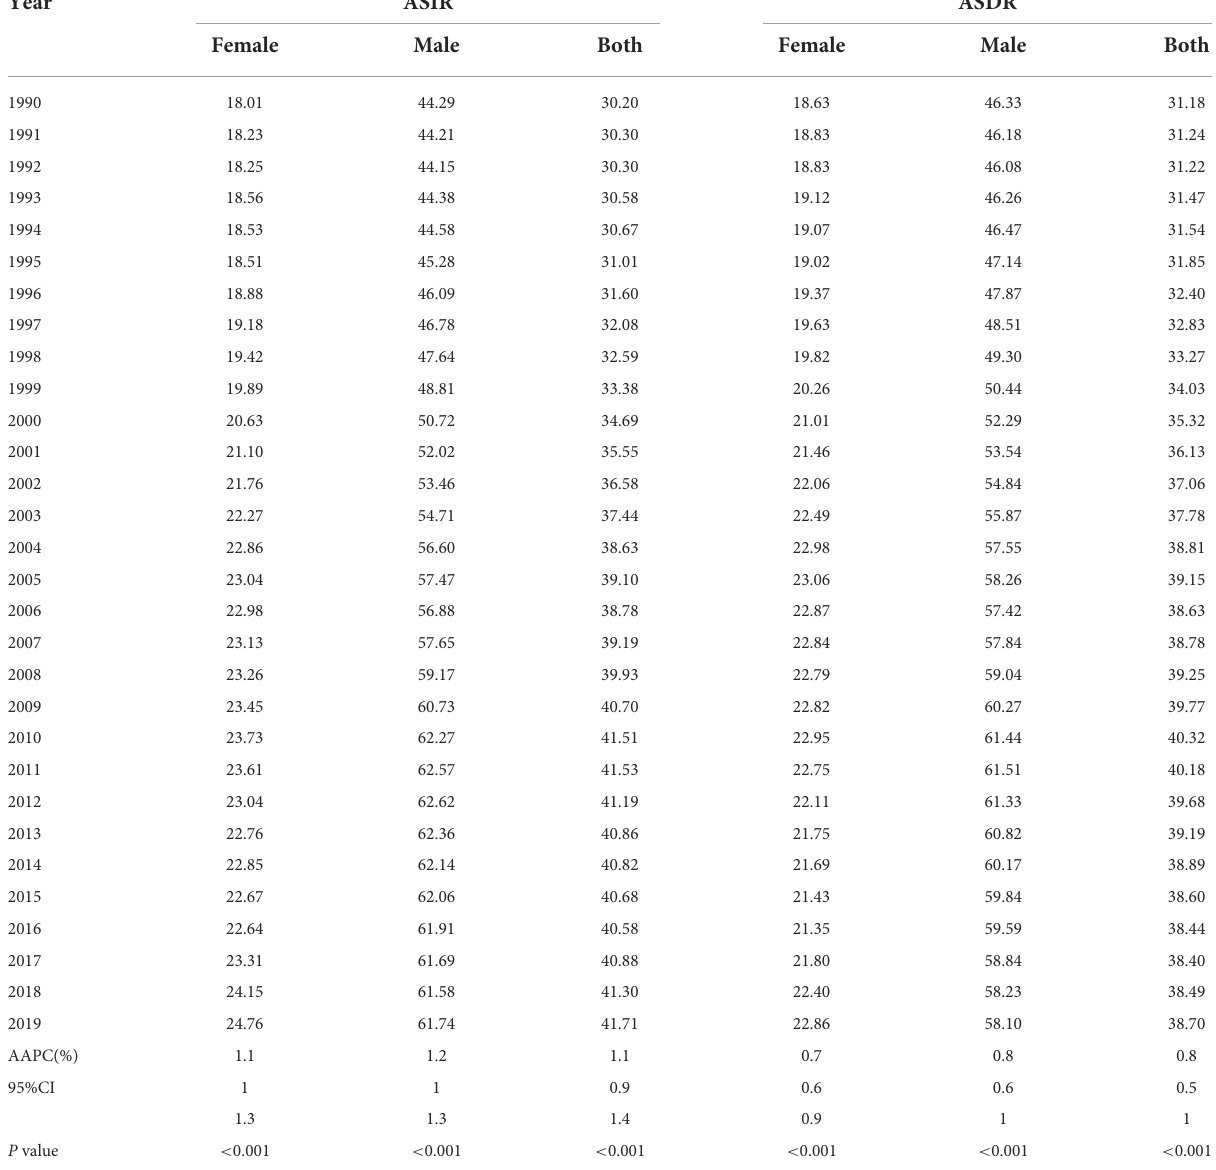
TABLE 1 Lung cancer incidence and mortality rates by sex in China, 1990–2019.